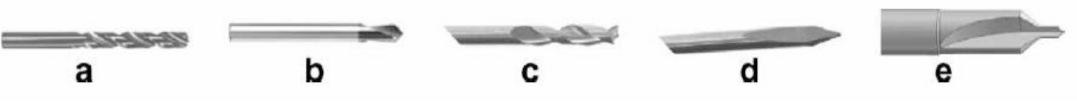
Figure 9. Drill bits investigated in respect of damages caused by drilling in composite laminates: ( a ) twist drill with a point angle of 120 ◦ , ( b ) twist drill with a point angle of 85 ◦ , ( c ) brad drill, ( d ) dagger drill, and ( e ) special step drill